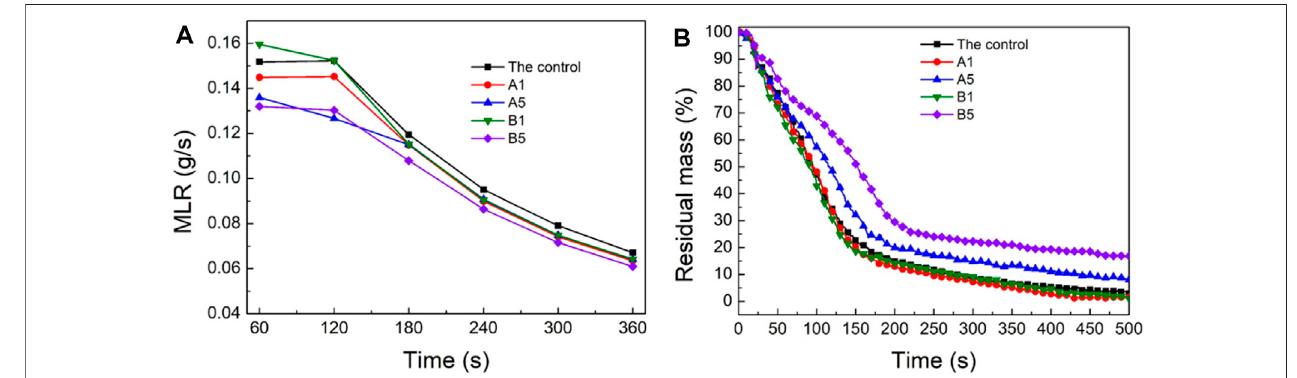
FIGURE 7 | MLR (A) in initial 360 s and residual mass (B) of bamboo specimens before and after LbL self-assembly with PA-PEI.